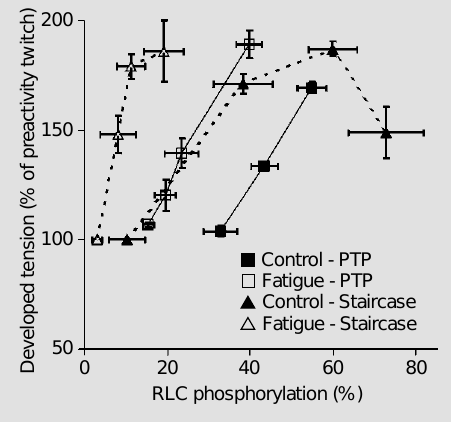
Figure 2 - Potentiation and myo- sin light chain phosphorylation of the rat gastrocnemius muscle for staircase (39) and posttetanic potentiation (PTP) (40). The re- sults for control and fatigued muscles refer to the situation in which potentiation was elicited before or after the fatigue proto- col, respectively. In both stud- ies, fatigue was induced by stim- ulation at 10 Hz for 5 min, fol- lowed by 20 min of test contrac- tions at 0.1 Hz. In both cases, the line representing the rela- tionship between potentiation and light chain phosphorylation is shifted to the left by fatigue. Note that the slope of the line representing staircase in the fa- tigued muscle is steeper than the other lines. This may repre- sent an additional mechanism of potentiation during staircase in fatigued